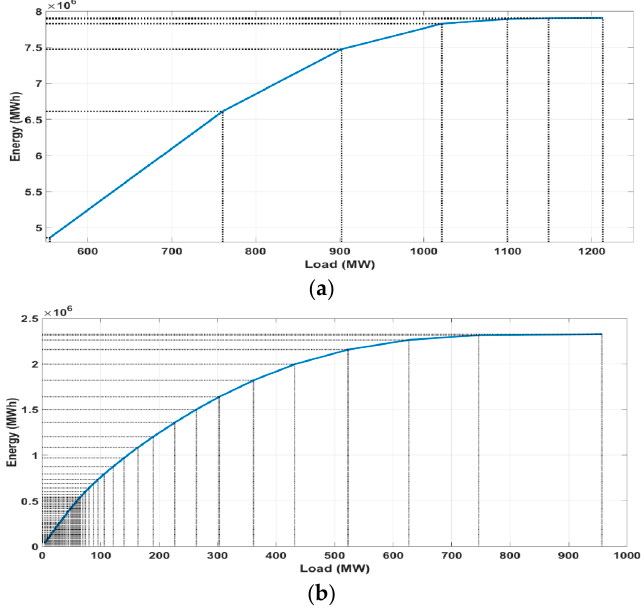
Figure 8. Piecewise linear load-energy curves for the first project year: ( a ) Electricity load; ( b ) Heat load.